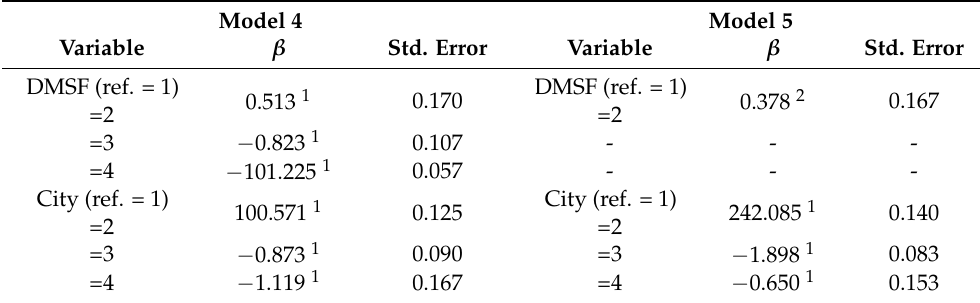
Table 6. Results of multinomial ordered logit estimates for testing Hypothesis